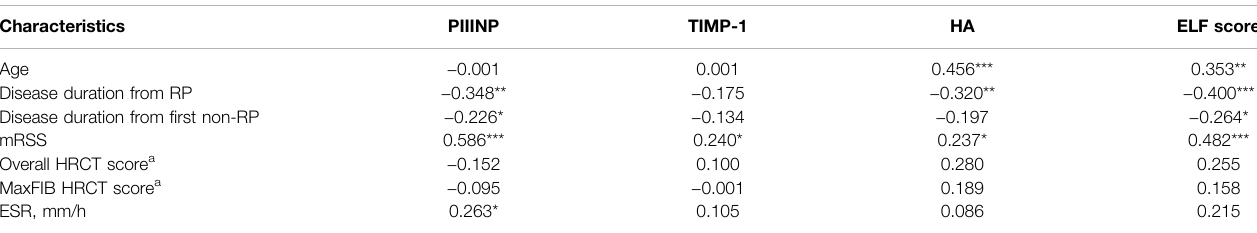
TABLE 3 | Correlation coef fi cient (r) between PIIINP, TIMP-1, HA, ELF score and continuous clinical variables in patients with SSc.